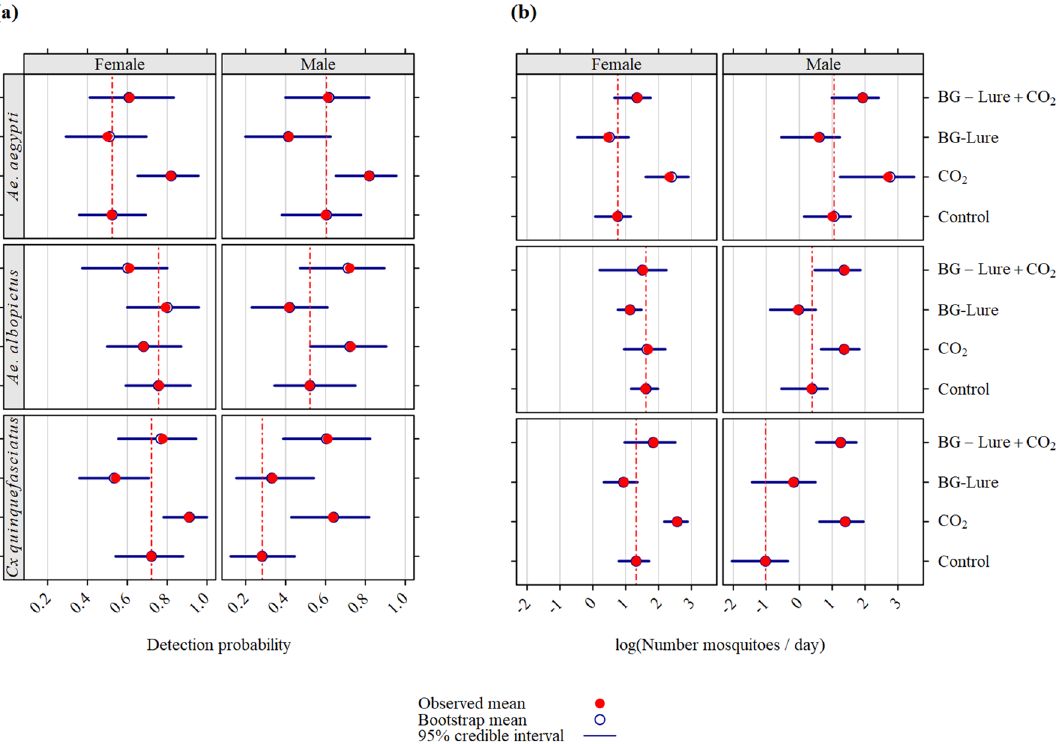
Figure 1. Observed detection probability (a) and apparent density (b) for well-established adult Aedes aegypti , Ae. albopictus , and Culex quinquefasciatus populations in two study sites located in La